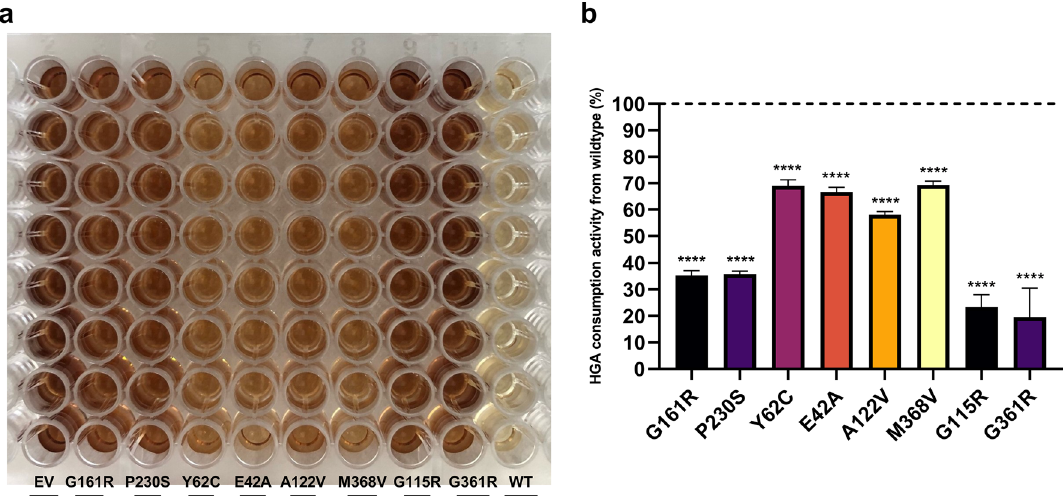
Figure 7. Evaluation of eight HGD missense variants based upon their residual HGD activities. Variants were generated via SDM and polymerase chain reaction (PCR) products were subsequently transformed into E. coli BL21 (DE3) cells. E. coli BL21 (DE3) cells containing pET42b-HGD WT, pET42b-HGD variants and the EV control were pre-grown and protein expression was induced as described in the Materials and Methods section. Simultaneously, 2.5 mM HGA was added to all cultures and a 96-well plate was filled according to ( a ) and incubated at expression temperature 30 °C. After 24 h incubation time, pyomelanin absorbance measurements were performed and residual HGD activities could be calculated following Eq. 1 ( b ). Significant differences compared to HGD WT control were calculated with a parametric one-way analysis of variance (ANOVA) followed by a Dunnett’s post-hoc test to correct for multiple comparisons. Data are expressed as mean ± standard deviation with **** p ≤ 0.0001. Calculated percentages of residual HGD activity were 70.37 ± 3.08% (for M368V), 68.78 ± 6.40% (for E42A), 58.15 ± 1.16% (for A122V), 69.07 ± 2.26% (for Y62C), 35.26 ± 1.90% (for G161R), 35.86 ± 1.14% (for P230S), 23.43 ± 4.63% (for G115R) and 19.57 ± 11.00% (for G361R). These results indicate